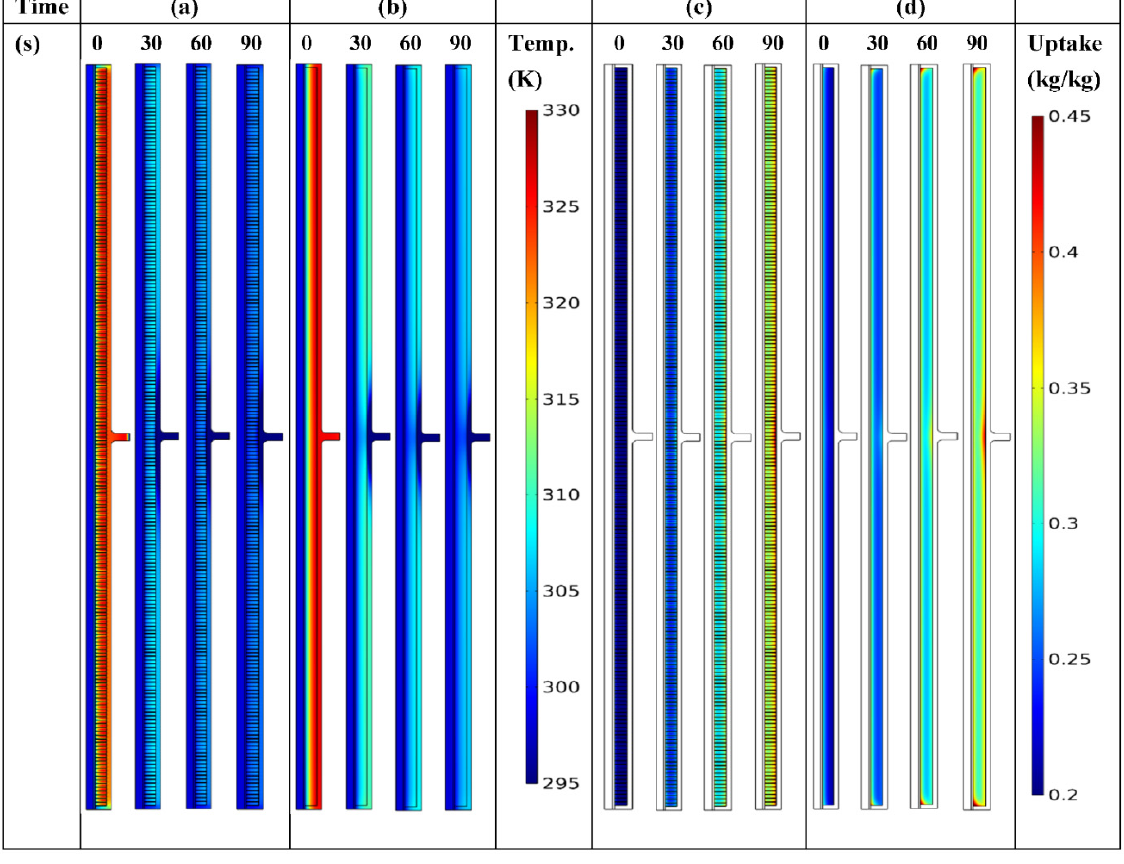
Table 3. The performance indicators of the finned ‐ tube base model at 2 mm fin height .